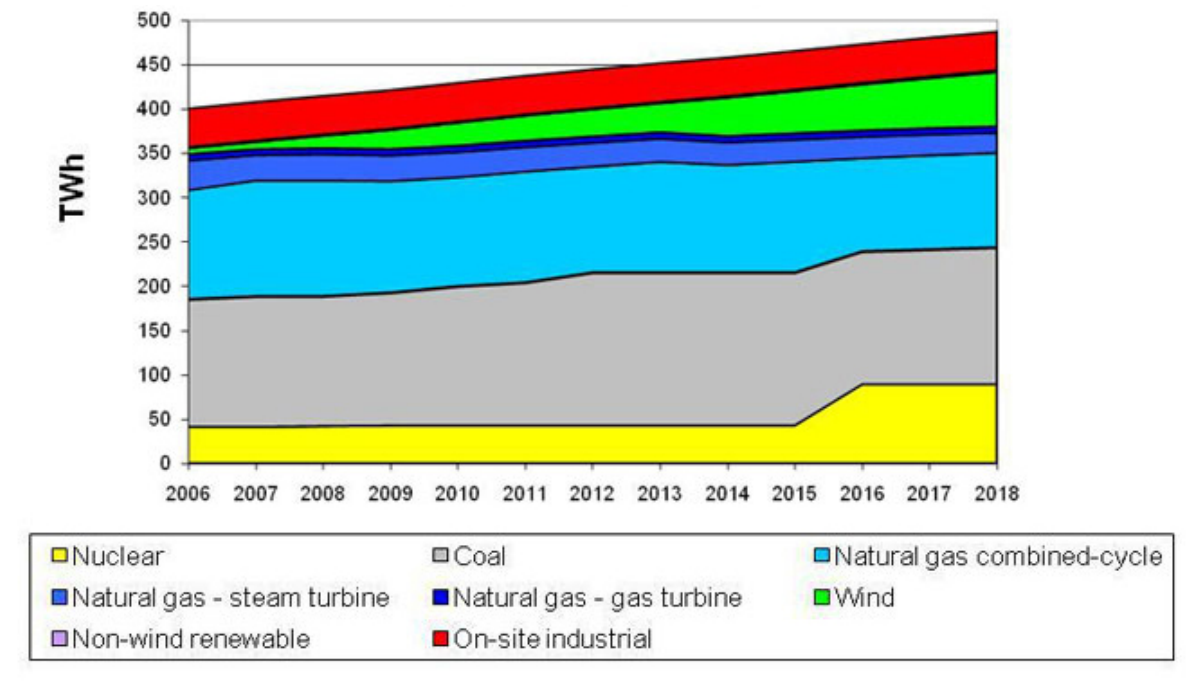
Fig. 7 . Projections for Texas electricity generation under a business-as-usual scenario show growth to 490 terawatt-hours (TWh) by 2018 (Webber et al.